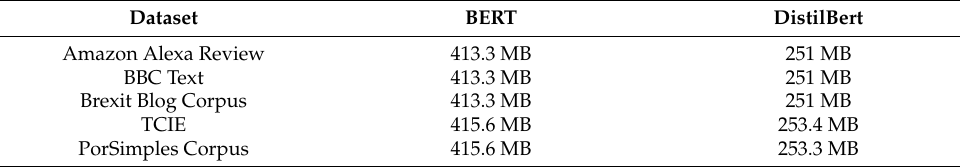
Table 18. Model Size.